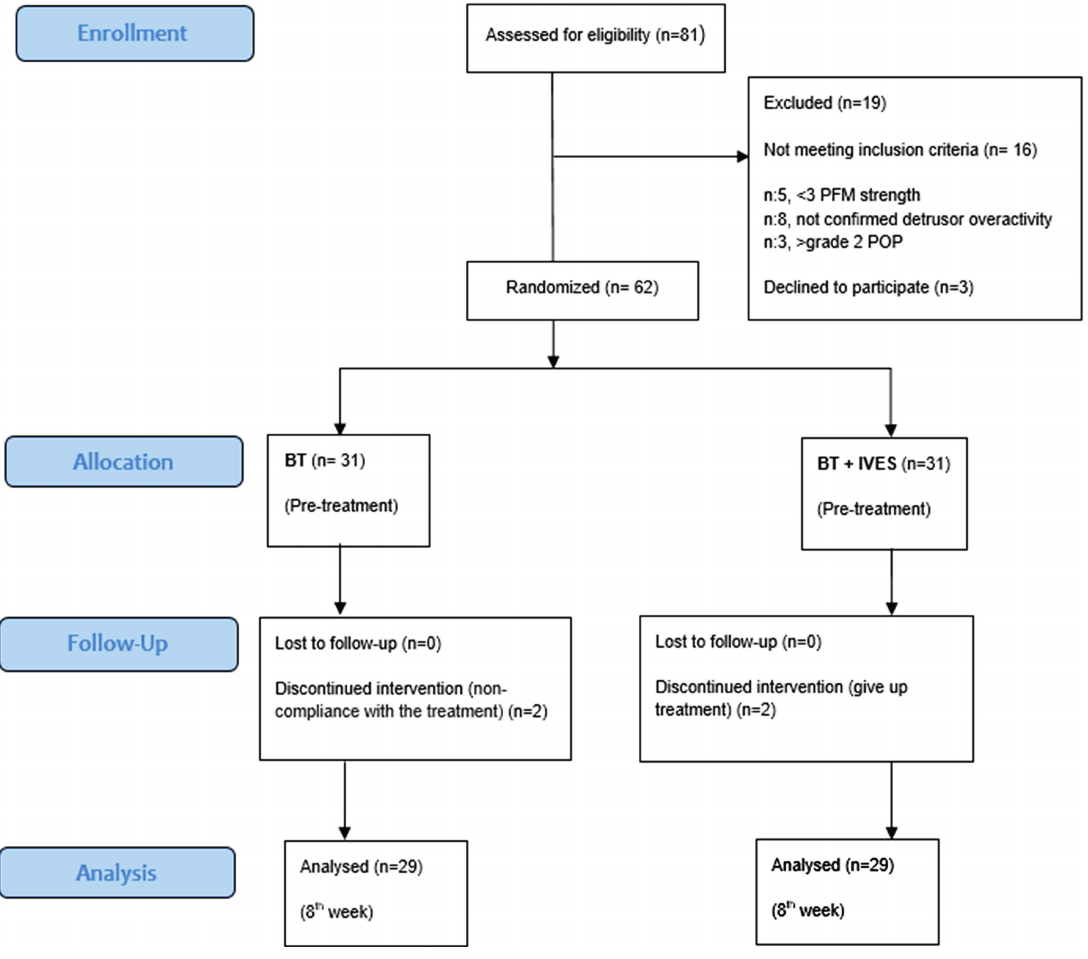
Figure 1 - CONSORT participant flow diagram for randomized, controlled trials of nonpharmacologic treatment, BT, Bladder training; IVES, Intravaginal electrical stimulation; PFM, pelvic floor muscle; POP, pelvic organ